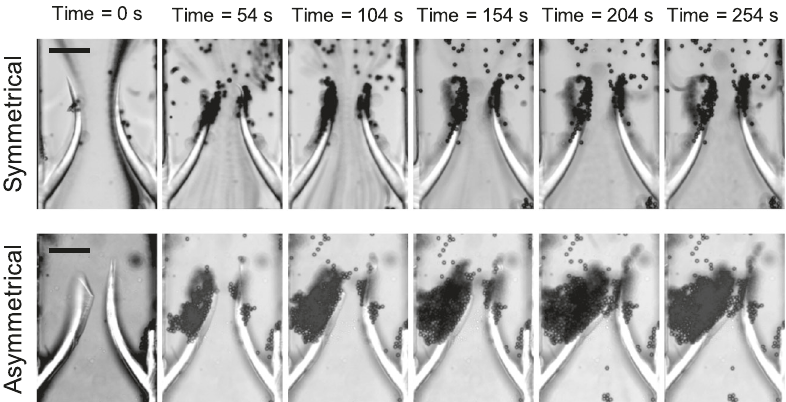
Fig. 5 Accumulation behaviour for symmetrical and asymmetrical valves. Time-lapse images of particles building up over time on symmetrical (top) and asymmetrical (bottom) valves; both are 4% (w/v) PI and 50% (w/v) PEGDA but the right-hand side lea fl et on the asymmetrical valve was exposed to UV light for a longer time compared to the left-hand side lea fl et (500 and 300 ms, respectively) resulting in an asymmetrical stiffness. The scale bars represent 100 µ m.